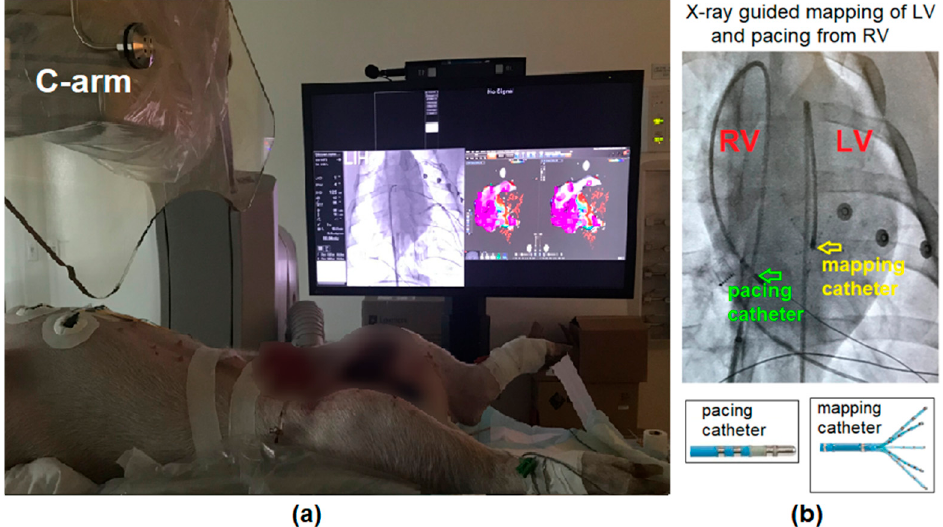
Figure 4. ( a ) Experimental set-up of the EP study (electro-anatomic mapping and arrhythmia study) shown during the intervention in pig #3, at week 9 following the completion of DOX injections; and ( b ) X-ray image of the mapping and pacing catheters inside the heart during the EP